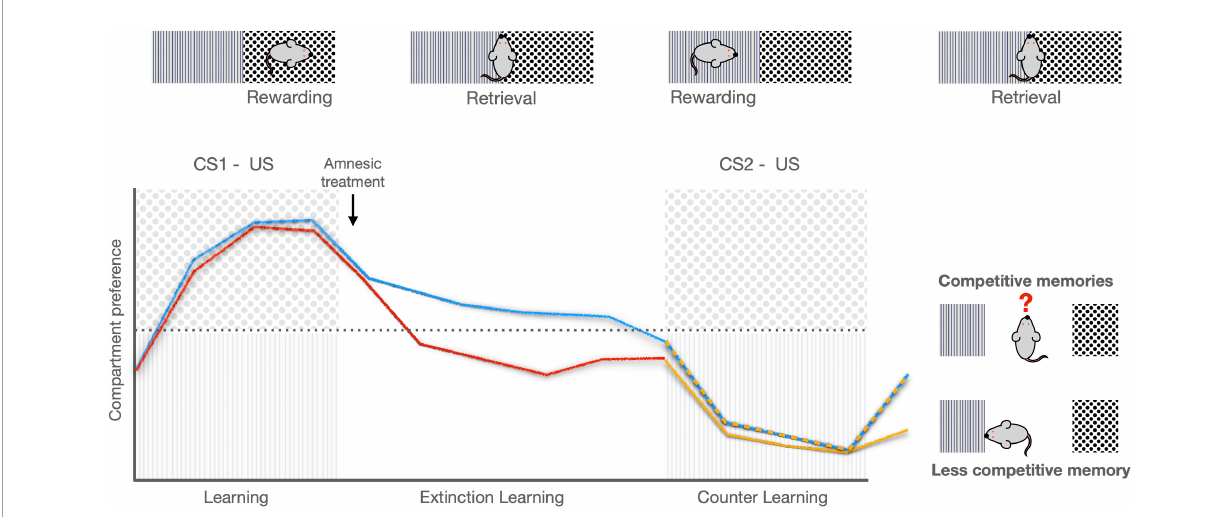
FIGURE3 Contextual memory updating. Animals were trained to prefer a compartment (CS1) with a rewarding stimulus (ventral tegmental area photo-stimulation; unconditioned stimulus, US). During the extinction training sessions, control animals are exposed to the conditioned stimulus (CS) without US, initiating extinction learning. The group of treated animals (red) received an amnesic treatment in the insular cortex (NMDA receptor antagonist) and place preference conditioning was extinguished. Then, both groups of animals were counter-trained in the other compartment (CS2) with the same rewarding stimulus. In the retrieval session, the control group maintains the original contextual memory that competes with the new contextual association (blue and orange-dashed line), indicating memory updating. However, the amnesic treatment disrupted the original memory, facilitating the association of new contextual cues with a rewarding stimulus (orange solid line) (Based on Gil-Lievana et al.,